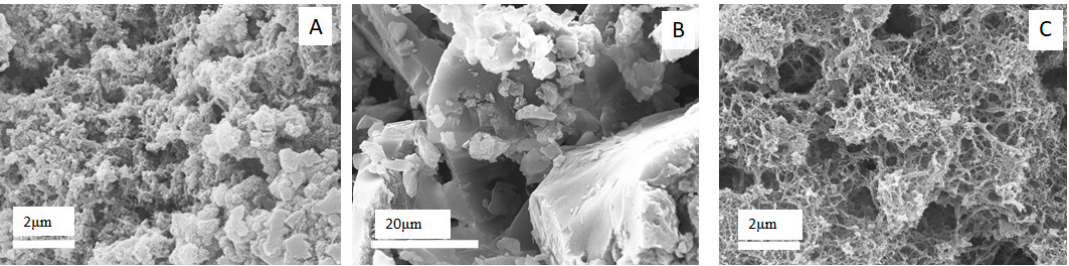
Figure 6. SEM images of PANI1_HCl ( A ), PANI2_HCl ( B ), PANI3_HCl ( C ).